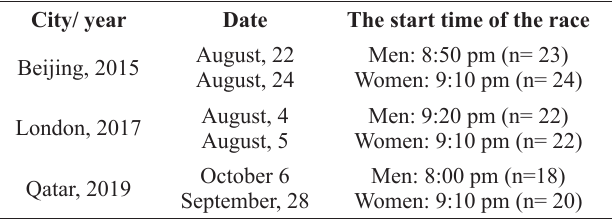
Table 1 - The races took place on the date and local time